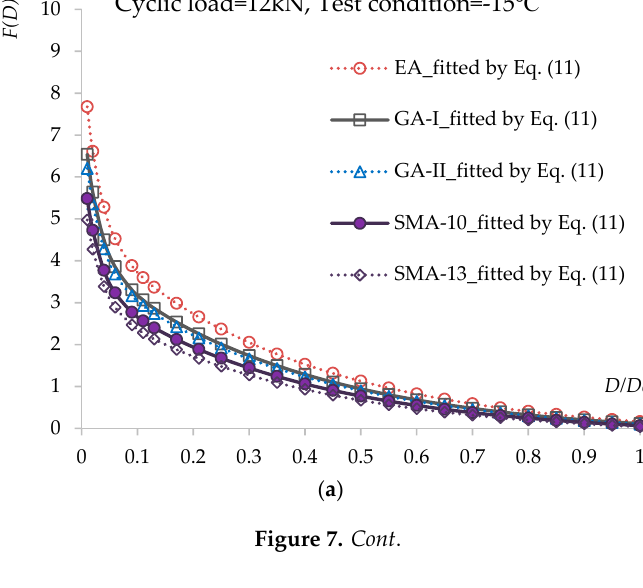
( a ) Figure 7. Cont